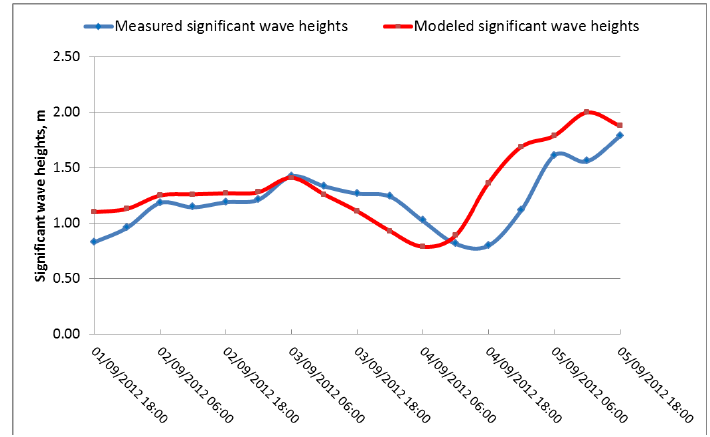
Figure 2. Comparison between measured and modelled significant wave heights in the Baltic Sea near-shore area along the coast of Klaipėda for a Nikuradse roughness parameter value of 0.005.